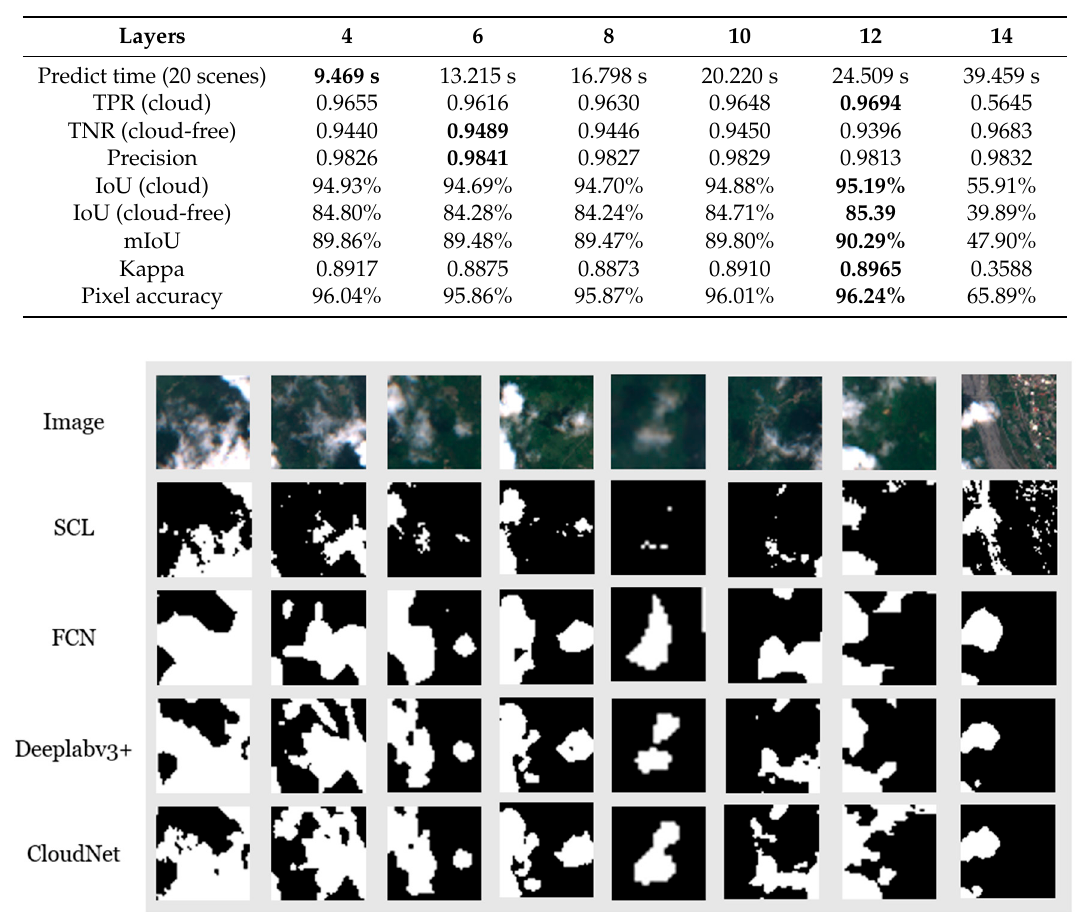
Figure 9. Visual evaluation of various DL architectures in classifying clouds, using eight regions with different types and forms of cloud presented as eight RGB images and predicted cloud